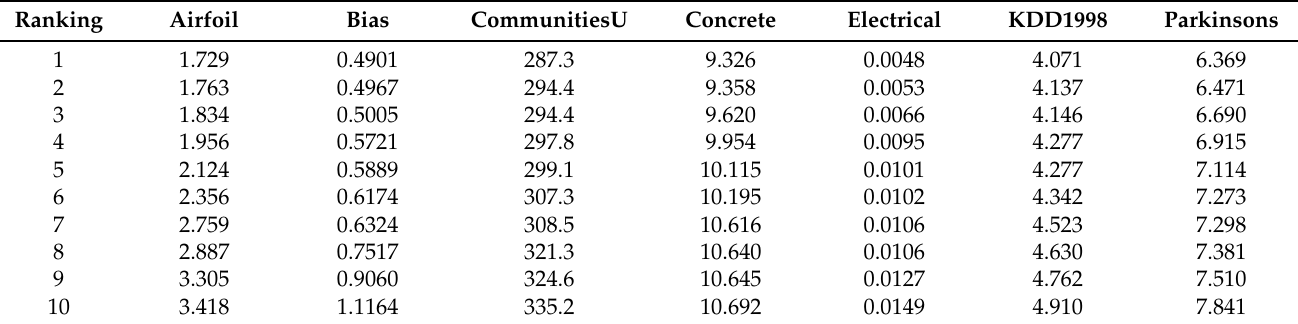
Table 6. Top 10 neural network